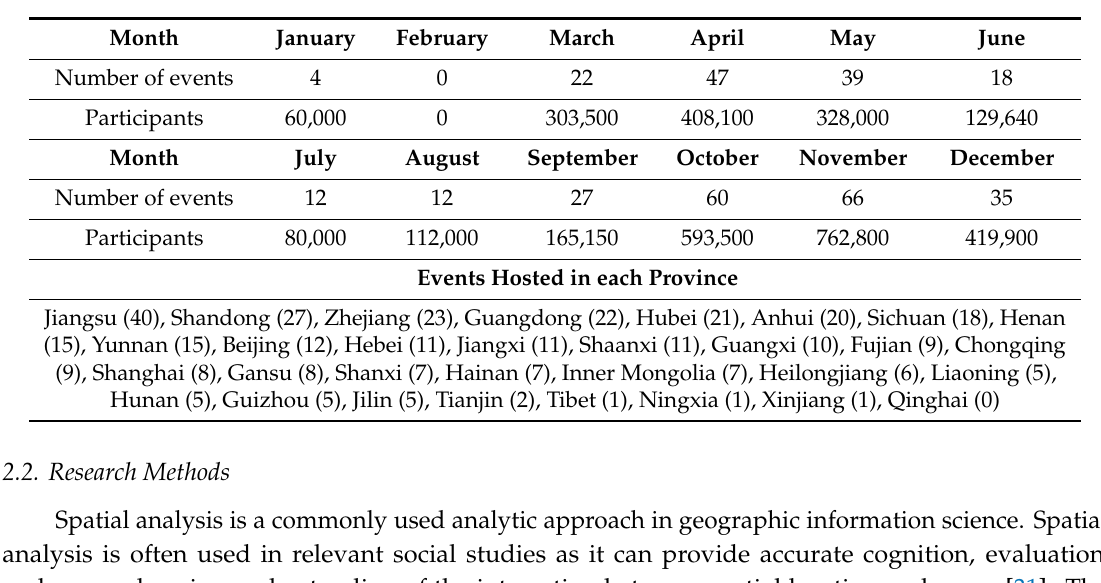
Table 1. Marathon events in China in 2018 (by